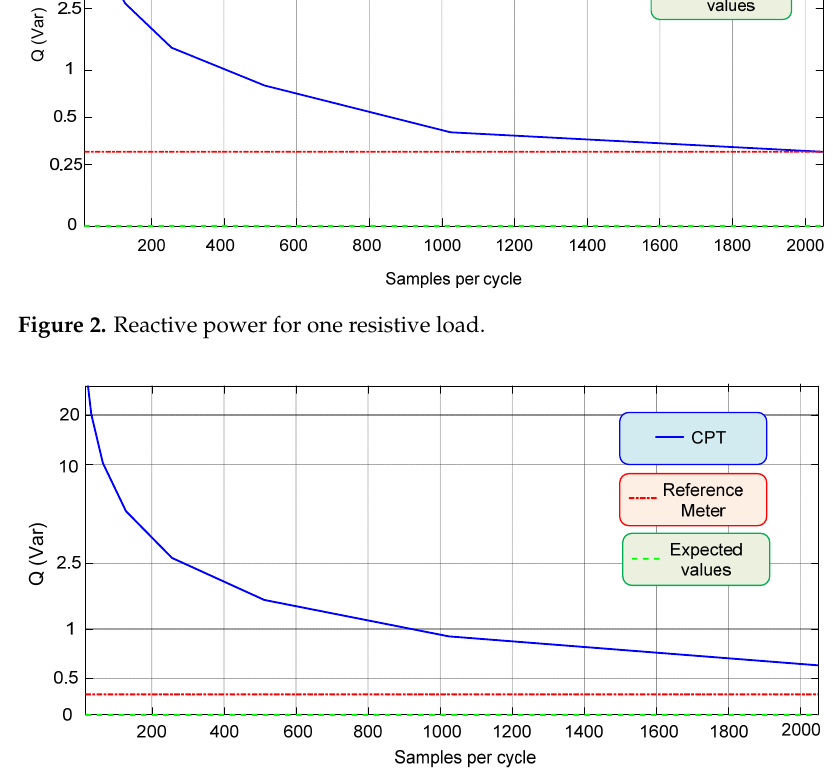
Figure 3. Reactive power for two parallel loads.